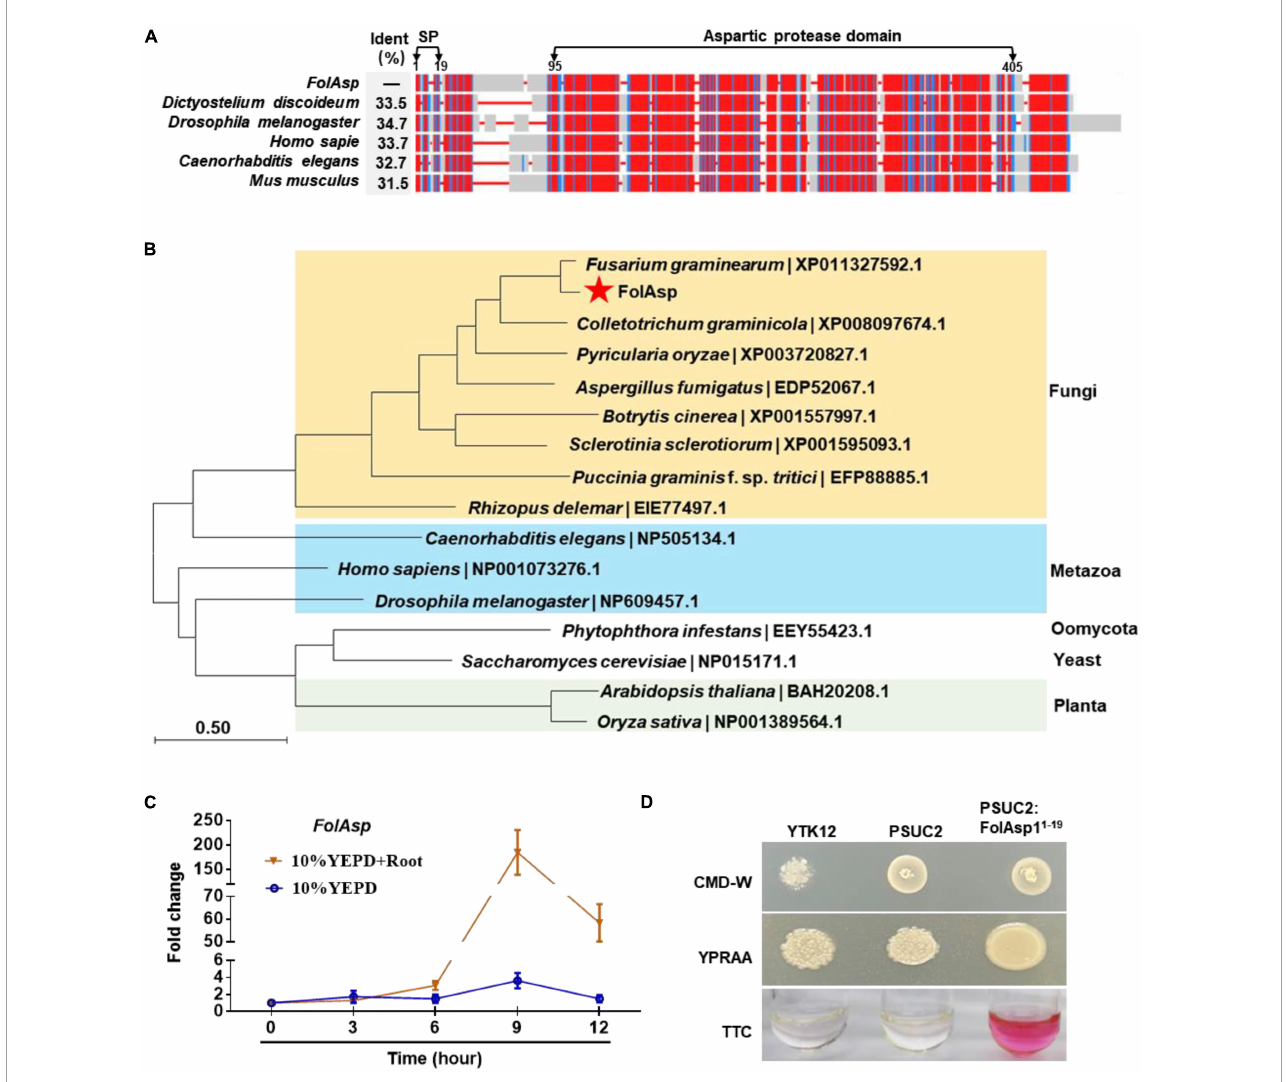
FIGURE1 Conservation, expression, and secretion analysis of FolAsp protein. (A) SmartBLAST was used to locate the regions of high sequence conservation in a graphical view among different model organisms. The identity (Ident) of the FolAsp and its homologs were as indicated. The predicted signal peptide (SP) and aspartic protease domain were marked on the top of the graph. (B) Phylogenetic analysis of Asp proteins in Fol and other species. The phylogenetic tree was generated by NJ method in MEGA. (C) Expression profile of FolAsp in Fol with tomato root induction at the indicated times measured by qRT-PCR. The expression levels were normalized to that of the histone H4 gene FolH4 . Data represent means ± SE of three independent replicates. (D) Functional validation of the signal peptide (1–19 amino acids) of FolAsp. The indicated strains were grown on CMD-W or YPRAA medium for 3 days. TTC was used to test the enzymatic activity of reducing TTC to red